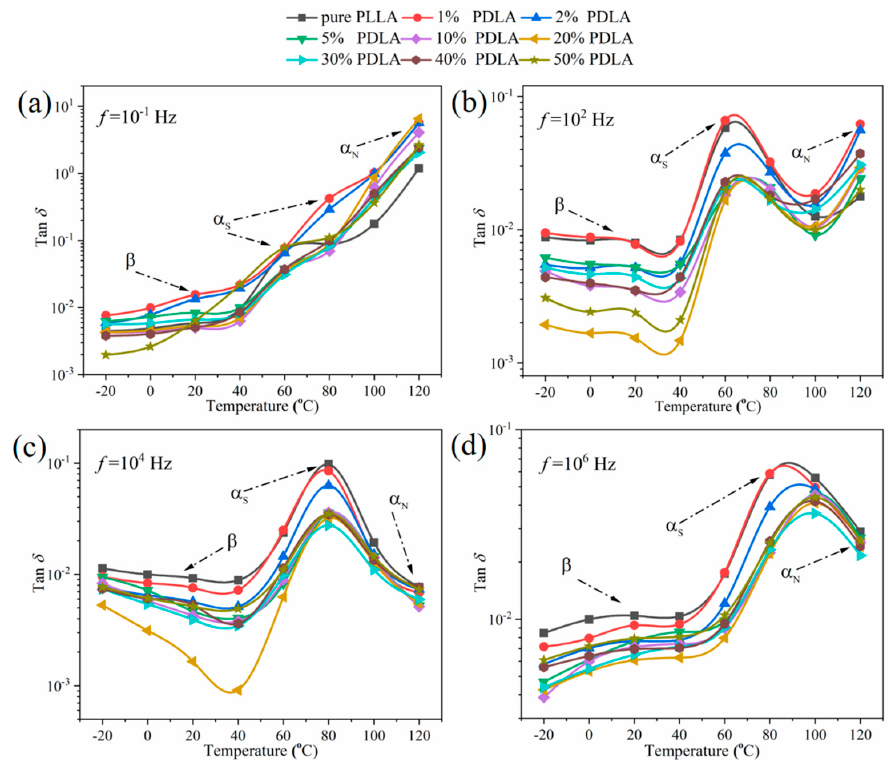
Figure 7. Temperature dependence of dielectric loss of pure PLLA and PDLA/PLLA blends with different PDLA contents on the ( a ) 10 − 1 , ( b ) 10 2 , ( c ) 10 4 , and ( d ) 10 6 Hz, respectively.